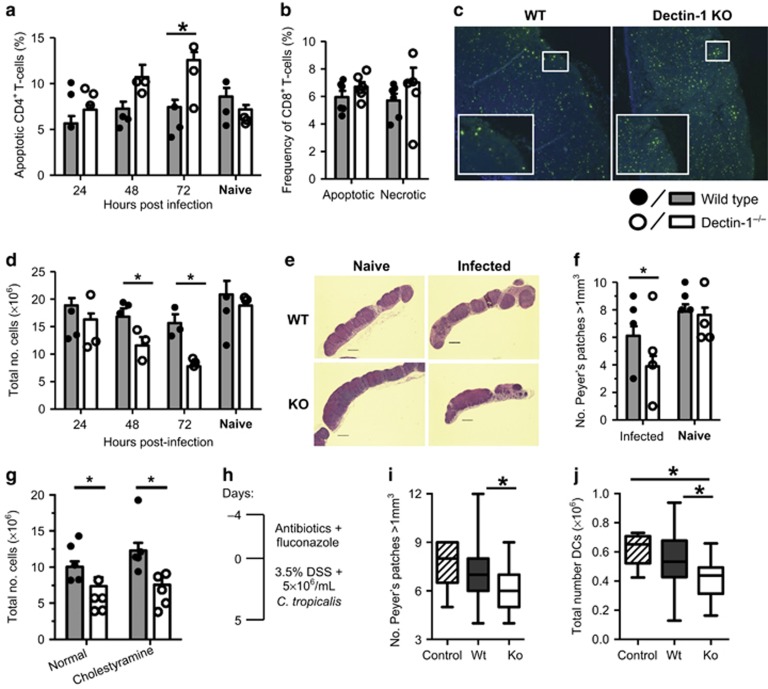
Dectin-1 is required for CD4+ T-cell survival. (a) The frequency of apoptotic CD4+ T-cells was measured by Annexin-V staining in mLN cell suspensions at the indicated time points post infection (WT n=9, KO n=9 at each time point). (b) CD8+ T-cell apoptosis and necrosis was measured by Annexin-V/7-AAD staining in mLN cell suspensions at 72 h post infection (n=6). (c) TUNEL staining performed on paraformaldehyde-fixed mLNs from infected WT and KO mice 72 h post infection; photo taken at 5 × magnification, insert at 40 × magnification. Blue=DAPI, green=apoptotic cells. (d) The total number of recoverable cells from the mLN (WT n=9, KO n=9 at each time point). (e) H&E staining of mLNs at 72 h post infection compared with naive controls (scale bars are 500 μm). (f) The total number of visible (>1 mm3) Peyer's patches (infected n=9, naive n=8) in WT and Dectin-1−/− mice at 72 h post infection. (g) The total number of recoverable cells from the mLN of infected WT (n=10) and KO (n=9) mice at 3 days post infection while maintained on cholestyramine diets, as described in Figure 1. (h) Schematic of the colitis model where co-housed WT and Dectin-1 KO animals were maintained on water supplemented with penicillin, streptomycin, and fluconazole for 4 days, and then switched to water containing 3.5% DSS and C. tropicalis for 5 days. The number of (i) Peyer's patches and (j) number of DCs (CD11c+MHCII+) isolated from mLNs from WT (n=20) and Dectin-1 KO (n=16) mice at 5 days post DSS exposure was compared with Candida only WT animals (control, n=6). Bar charts show pooled data (2–5 experiments); overlaid dot plots show one representative experiment. *P<0.05.